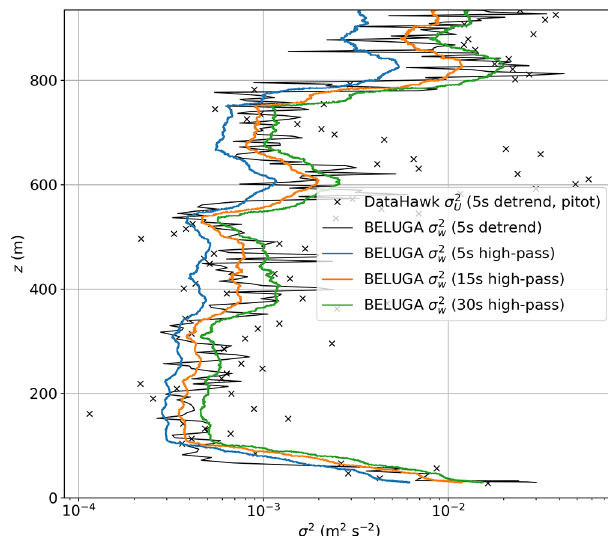
Figure 5. Comparison of different methods for calculating wind velocity variances σ 2 : vertical profile (first descent) for 13 July 2020. The black line represents BELUGA variances calculated from nonoverlapping, detrended 5s segments. The orange, blue, and green lines show BELUGA variances calculated in rolling windows after applying different high-pass filters to the time series. The black crosses result from DH2 5s pitot, filtered spectra, as described in the